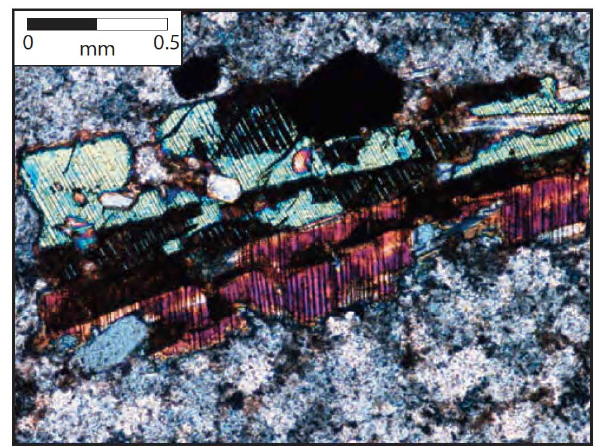
Fig. 5. Photomicrograph (sample YD23, crossed-polarized light) of a pigeonite crystal within unaltered microcrystalline matrix display- ing classic “Christmas tree texture”; a result of exsolution lamellae indicating high temperatures (especially for dacite-rhyolite compo-